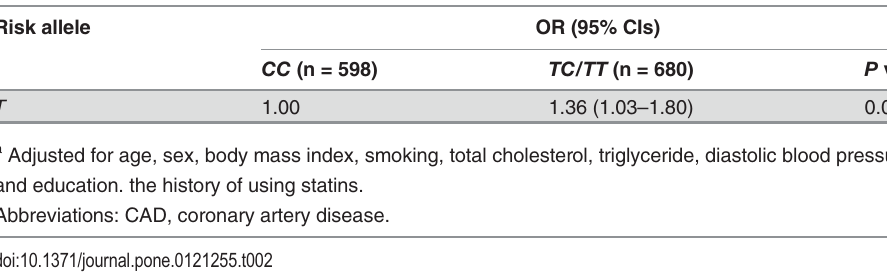
included in our multiple logistic regression models. Data showed that all the explanatory vari- ables are independent to each other and no multicollinearity was observed.